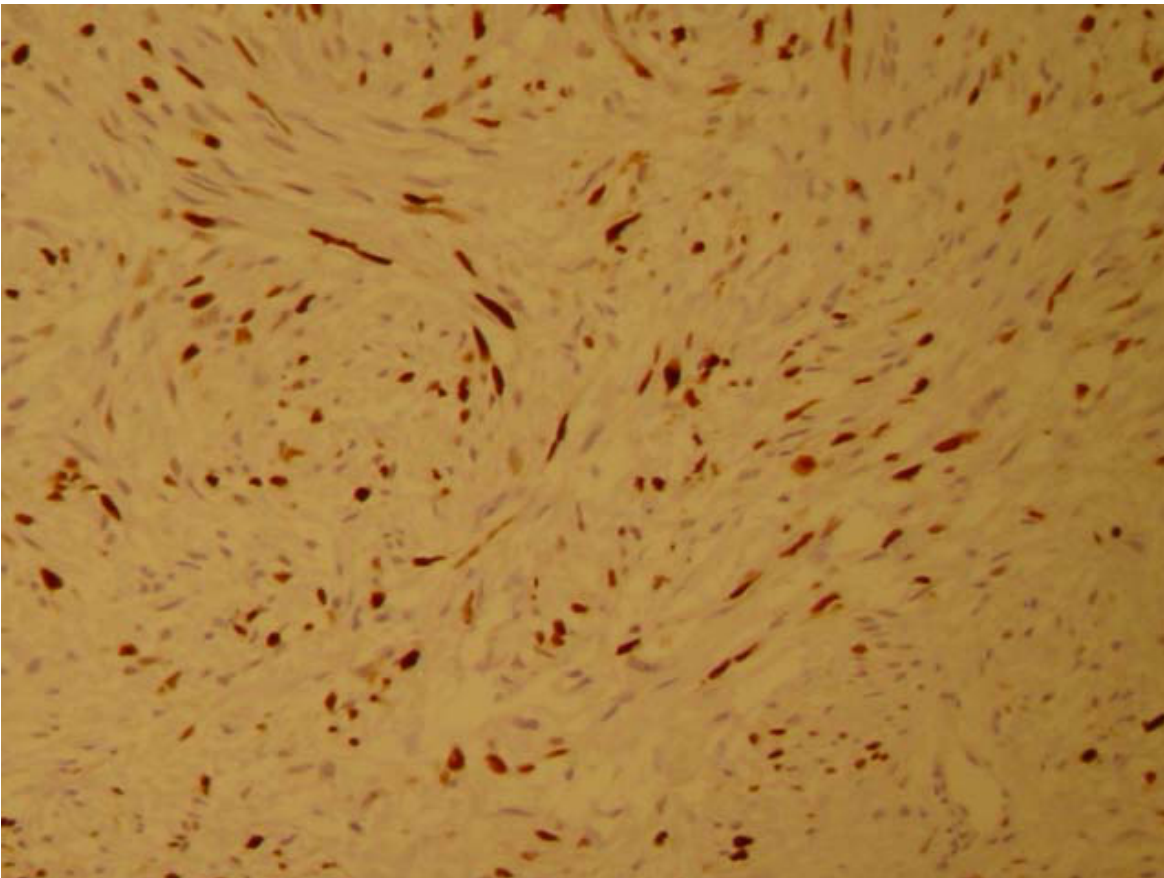
FIGURE 2 . Higher power H + E stain, demonstrating fascicles of spindle cells, areas of hyalinisation, oedema, and a central mitotic figure.